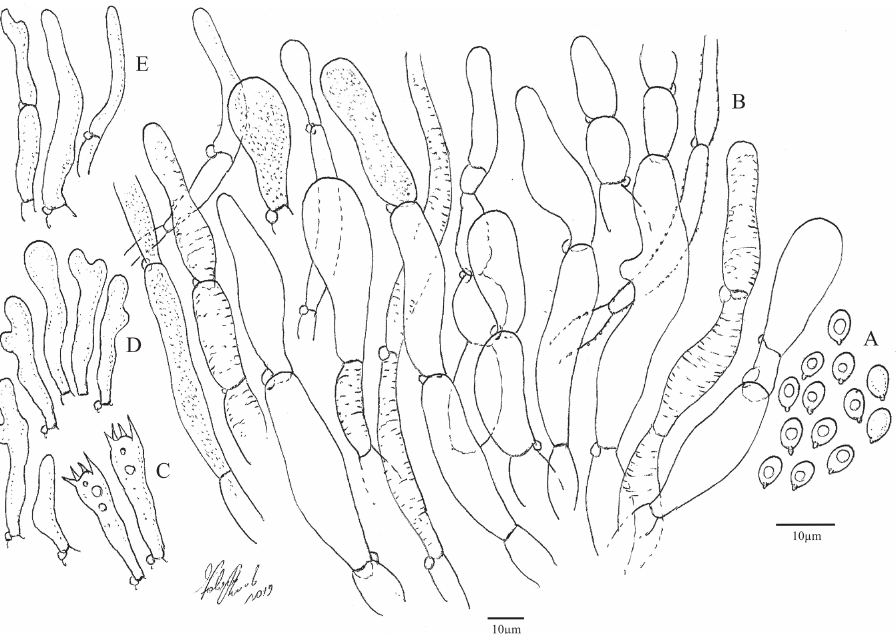
Figure 2. Micro-morphological features of Pseudobaeospora cyanea A basidiospores B pileipellis C basidia D cheilocystidia E caulocystidia (drawing F.